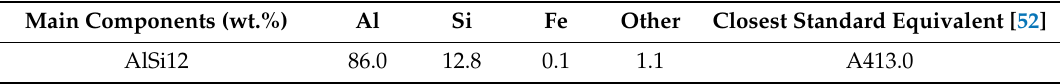
Table 2. Chemical composition of AlSi12